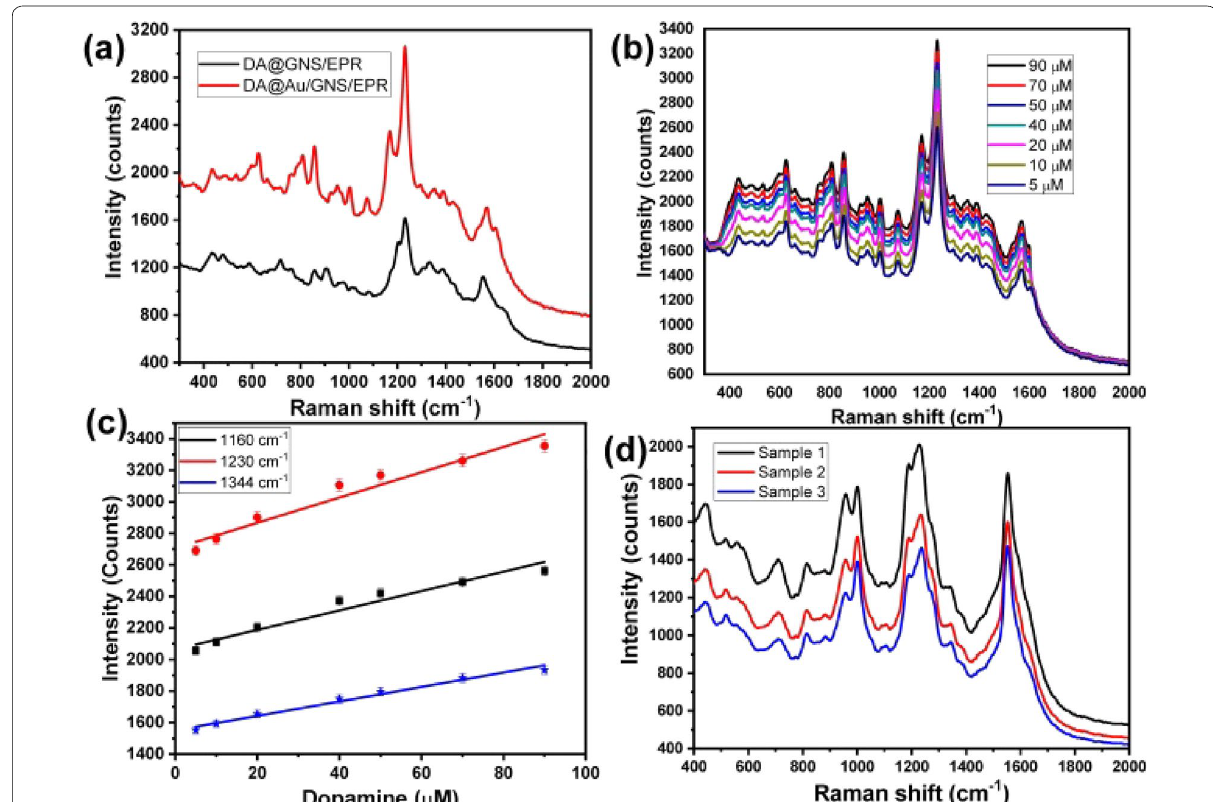
Fig. 8 Raman spectra of dopamine solution in PBS buffer by using GNS/EPR 5 and Au NPs/GNS/EPR 5 ( a ), G‑SERS spectra of different concentrations of dopamine dissolved in PBS buffer by using Au NPs/GNS/EPR 5 ( b ), the relationship between the intensities of SERS signals (857, 1074 and 1344 cm − 1 ) and the corresponding concentration of dopamine ( c ), and G‑SERS spectra of different concentrations of dopamine dissolved in human serum by using Au NPs/GNS/EPR 5 ( d